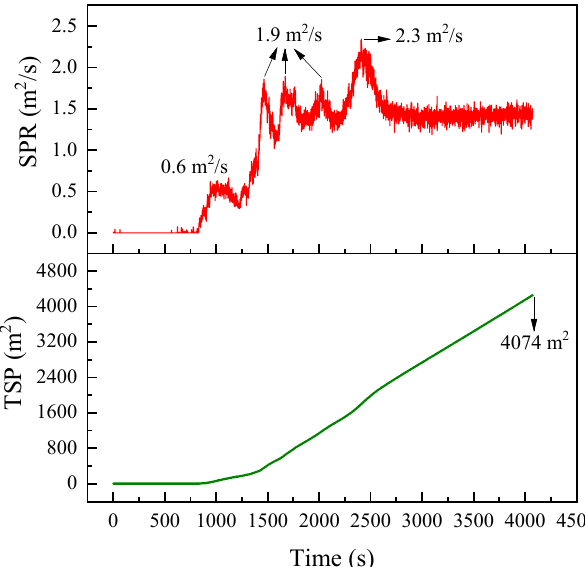
Figure 11. SPR and TSP during the LIB pack combustion process.